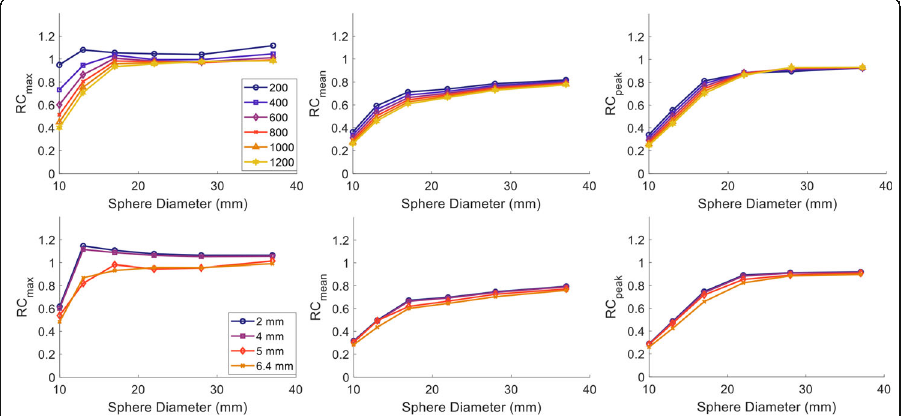
row) and PSF with varying post-reconstruction Gaussian filter width (bottom